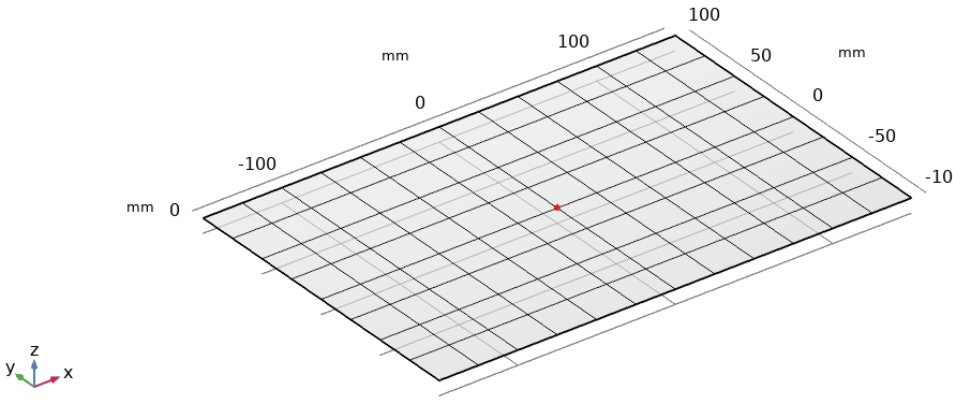
Figure 4. FEM model of the aluminum plate; the exciting point is highlighted in red.